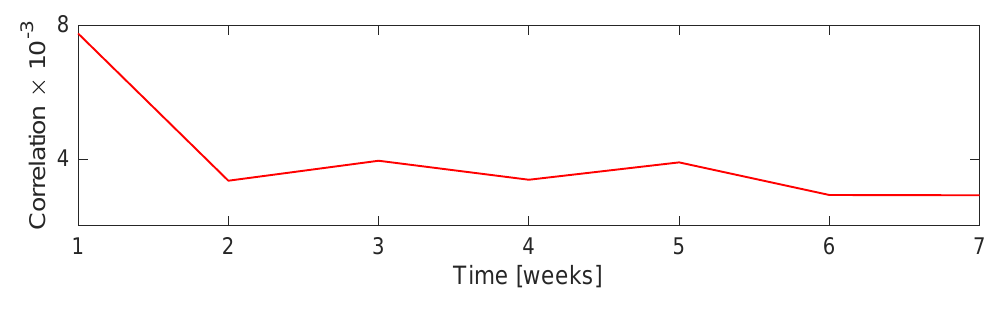
Figure 13: 150 nm ASIC chip, 90 ◦ C, 10 % over voltage, correlation coefficient for the correct key candidate using 5 million traces in each